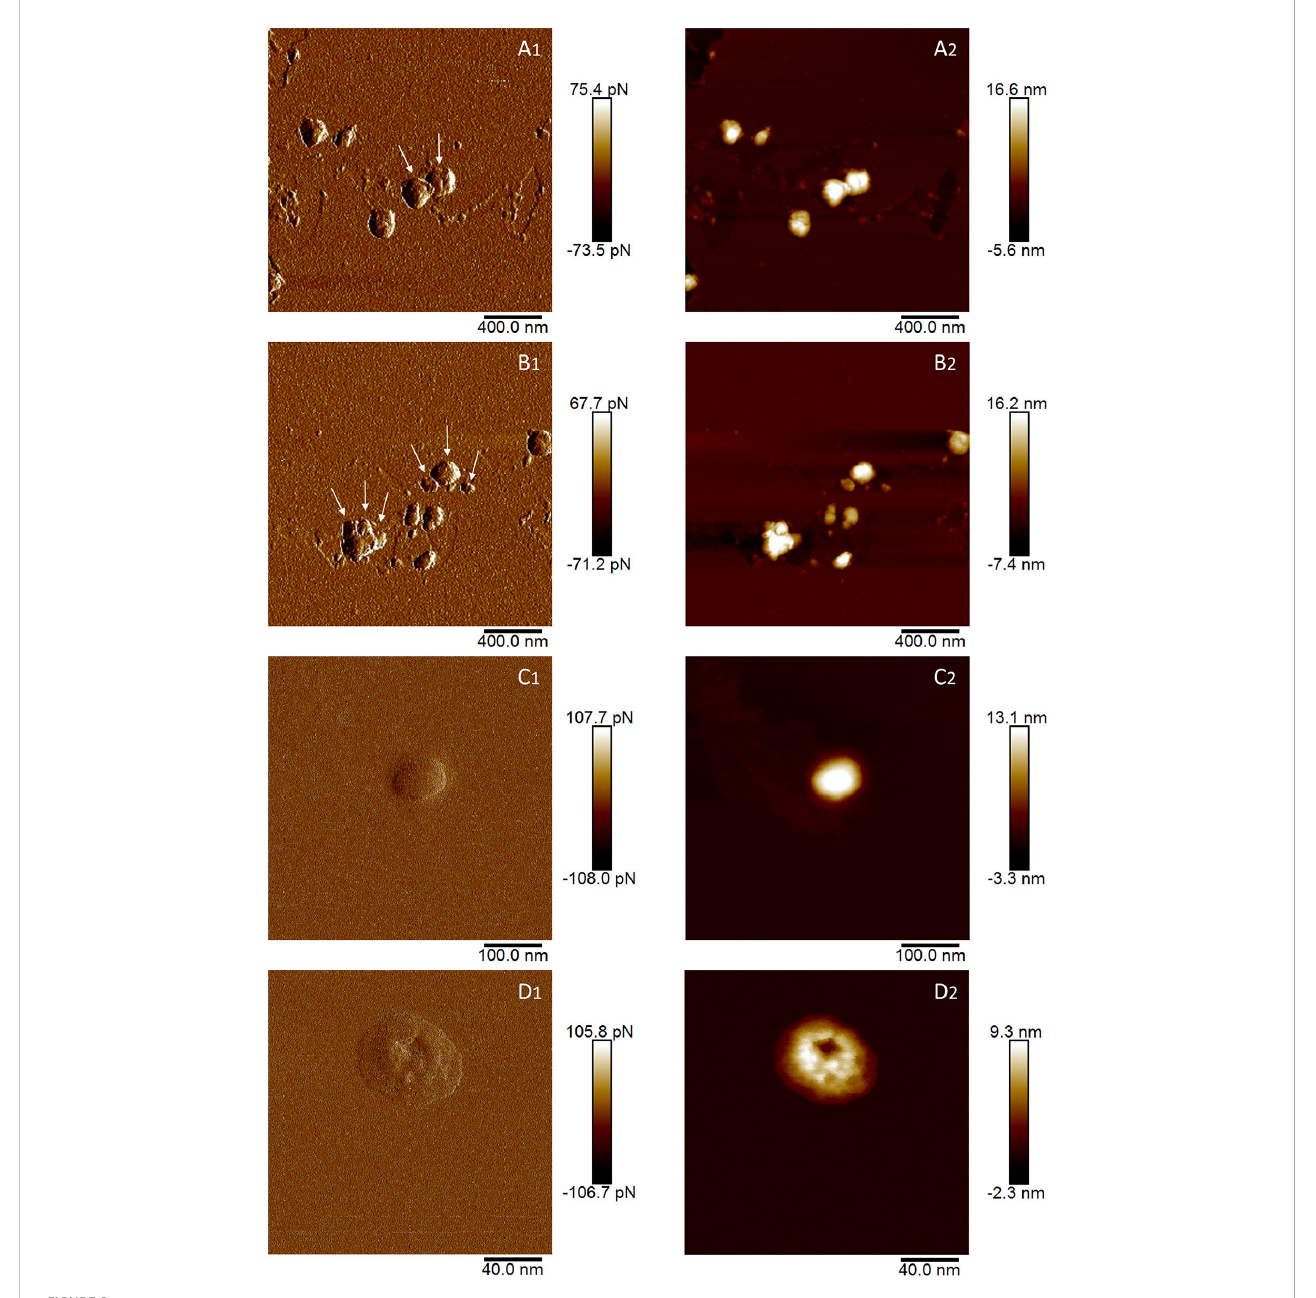
FIGURE 2 AFM images of EVs isolated from germinated (A, B) and hydrated (C, D) kiwi pollen. Images indexed with 1 (A1, B1, C1, D1) are captured in height mode, while images indexed with 2 (A2, B2, C2, D2) are captured in peak force error. In A1 and B1, arrows indicate plausible individual vesicles in vesicle